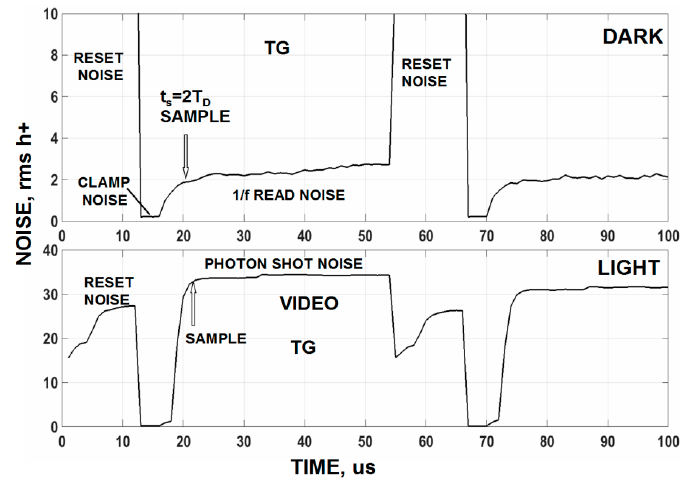
Figure 15. Noise levels for signal shown in Figure 14. The top dark plot shows how the read noise increases throughout the TG time period. No excess TG clock feed-through noise is